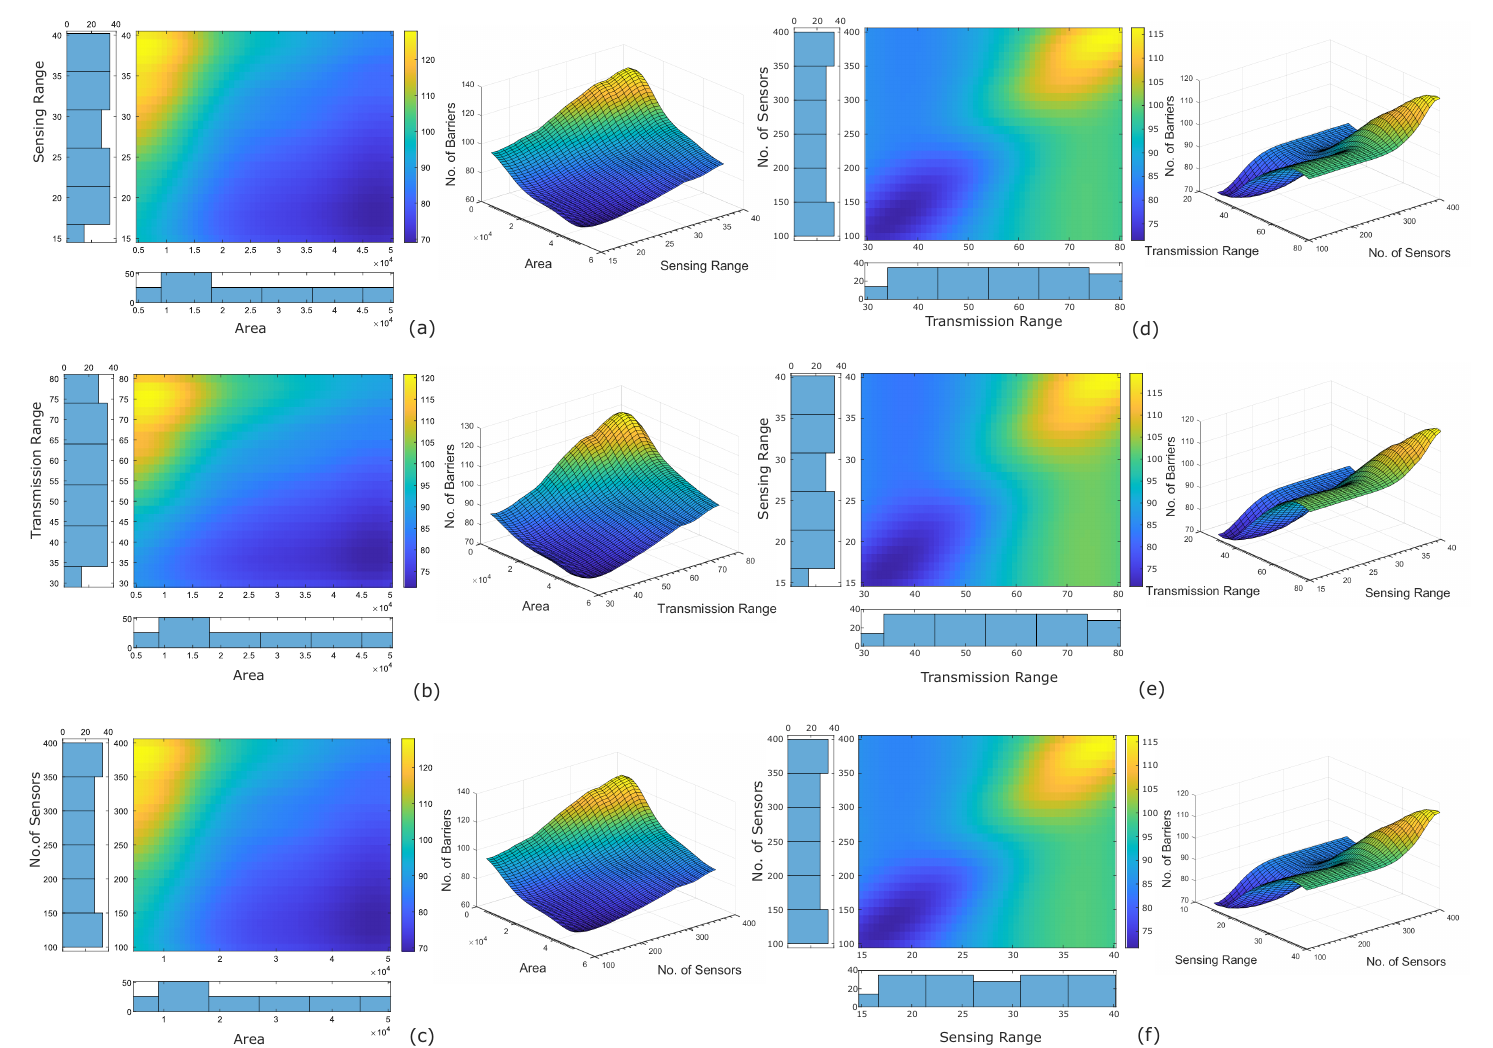
Figure 5. Feature sensitivity analysis through partial dependency plot. Two features are considered at a time (a total of six pairs from a – f ). The left image shows the 2-D variation profile (with histogram) for each pair, and the right image shows the corresponding 3-D variation